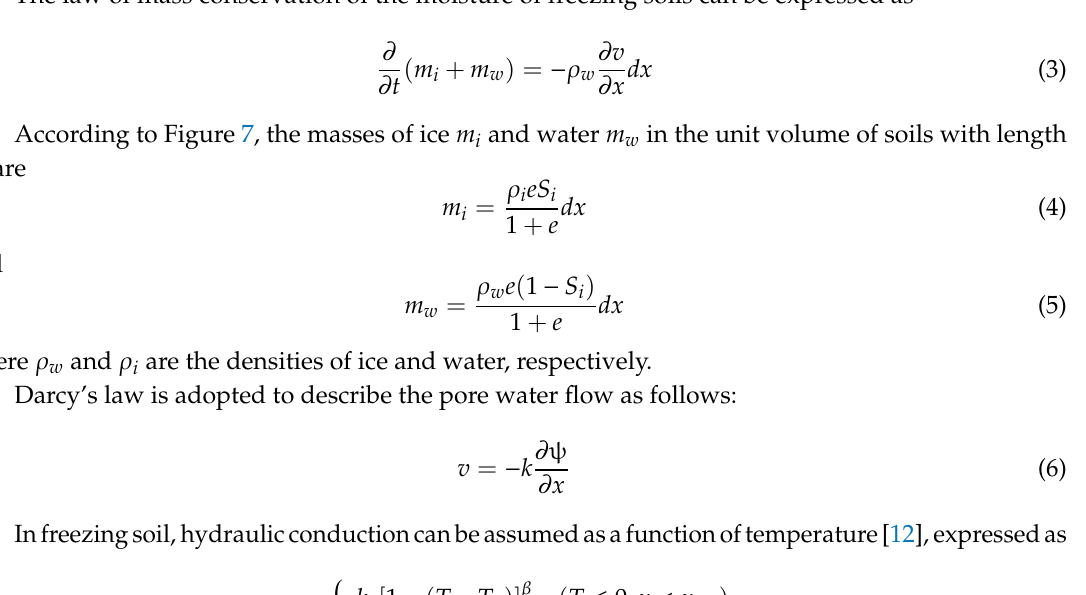
Figure 7. Three-phase sketch of saturated freezing soils.